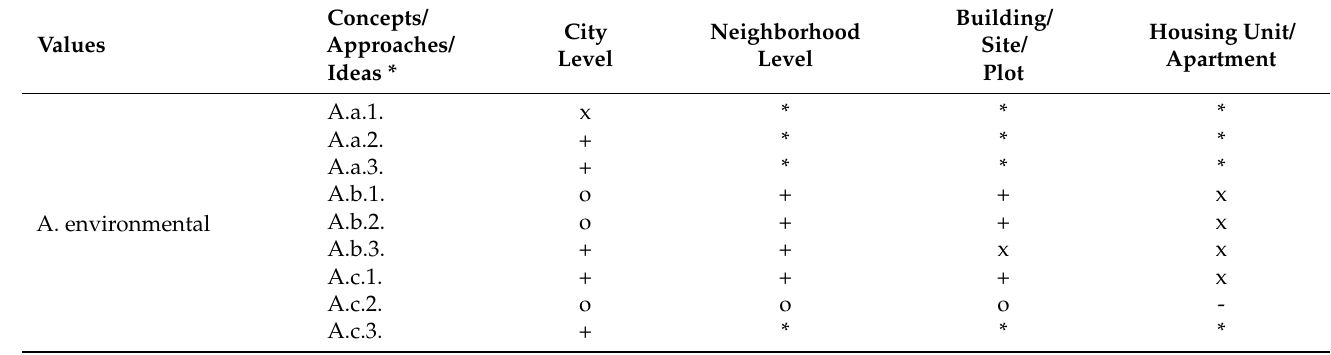
Table 3. Mapping the application of the EU design taxonomy within a national